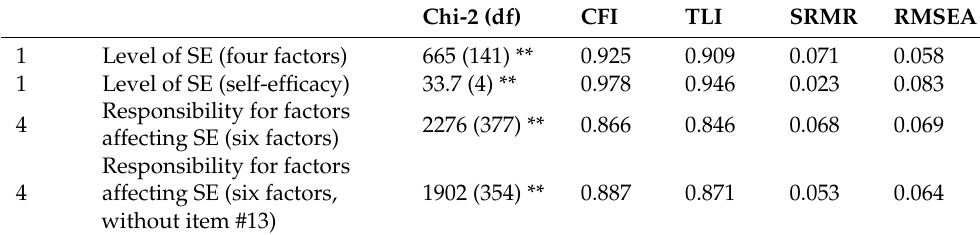
Table 4. Fit indices of the MAISE-Easy